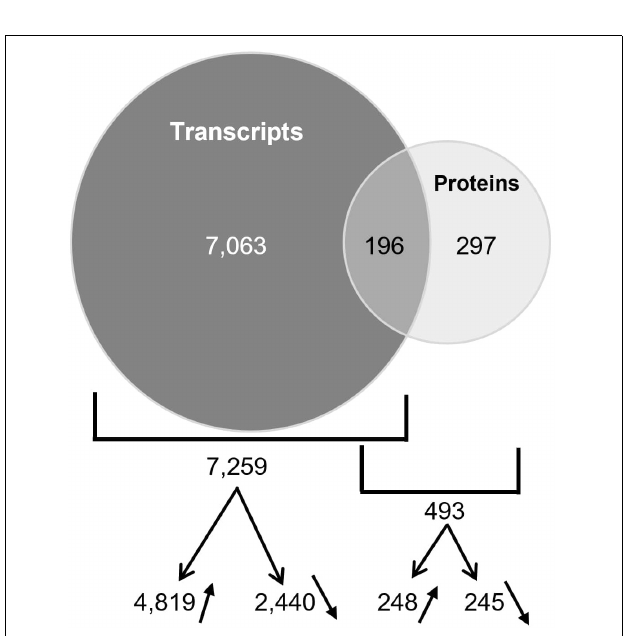
FIGURE 6 | Overlapping of transcripts and proteins differentially accumulated in R108. Venn diagram shows the genes that have a differential expression at the level of transcript only, protein only or both levels. The numbers of transcripts or proteins over- or under-accumulated are also indicated with arrows.